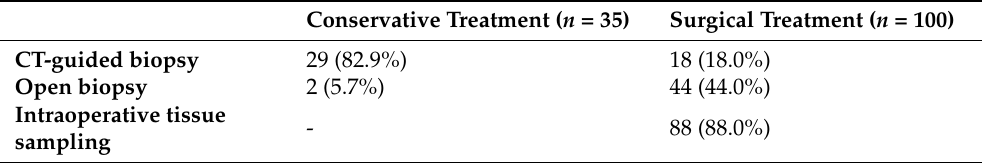
Table 1. Methods performed for pathogen identification in the two treatment groups.